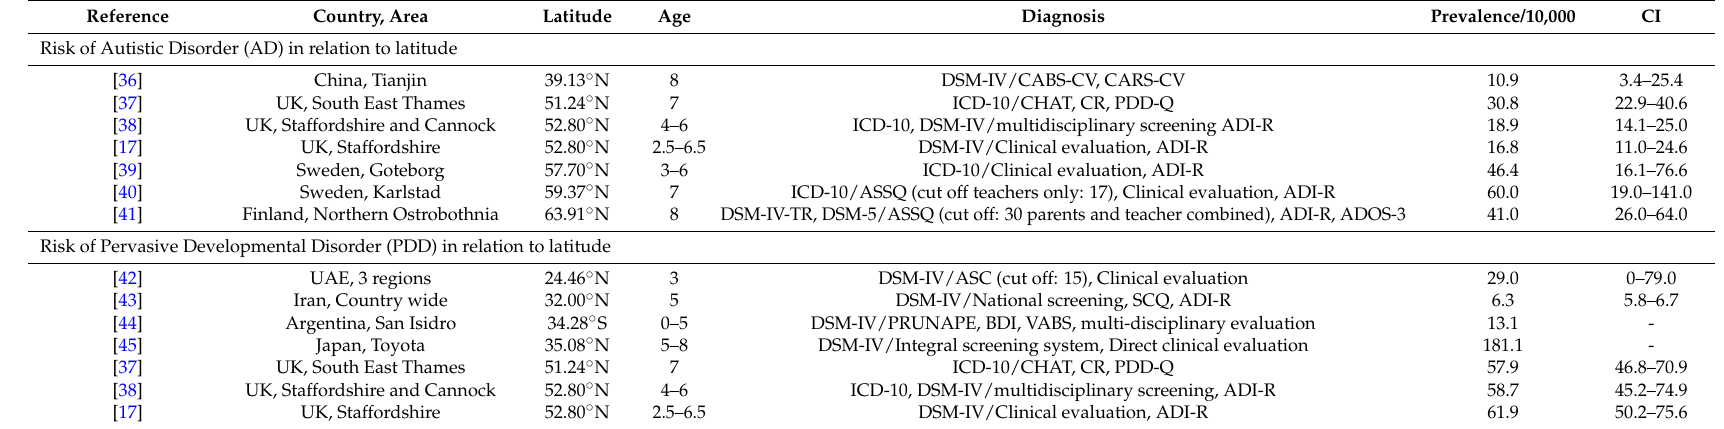
Table 1. Risk of Autistic Disorder (AD) in relation to latitude & Risk of Pervasive Developmental Disorder (PDD) in relation to